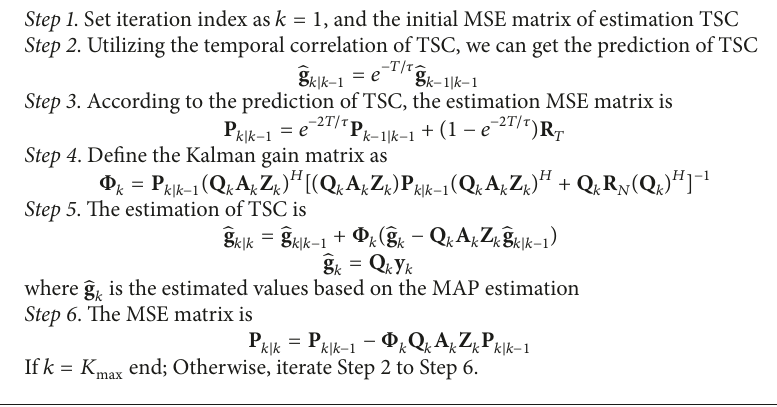
Algorithm 1: Kalman filtering for TSC estimation in CRC system.